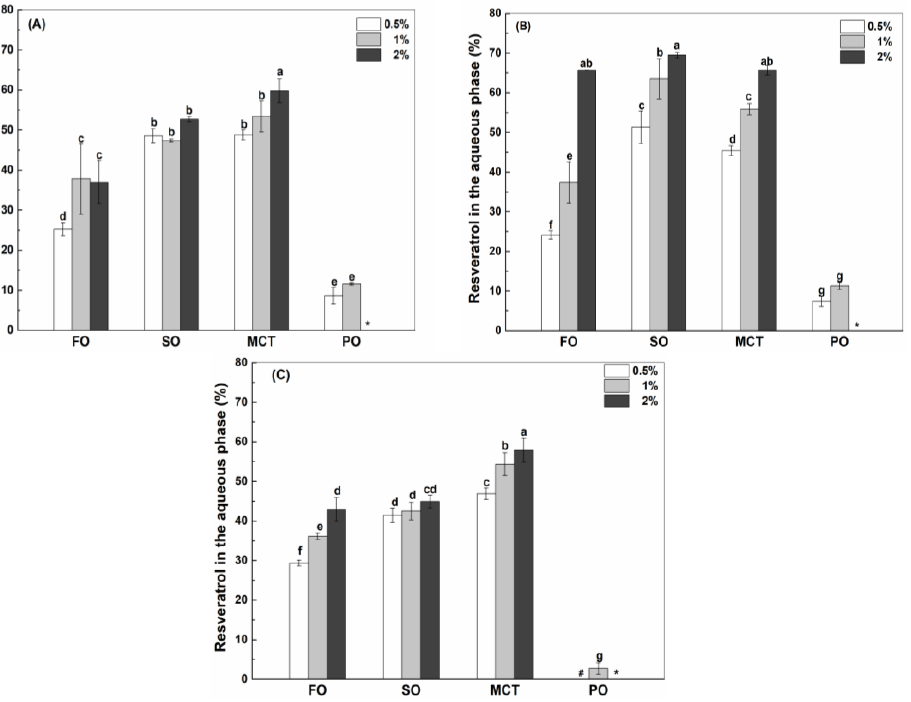
Figure 4. Percentage of resveratrol in the aqueous phase of fish oil (FO), sunflower oil (SO), MCT and peppermint oil (PO) emulsions stabilized by native WPI ( A ), heat-denatured WPI ( B ) and sodium caseinate ( C ) at 0.5%, 1% and 2%. Different letters mean significant differences at p < 0.05. * Peppermint oil emulsions were unstable at 2% proteins. # Resveratrol was not detected. For the use of WPI as an emulsifier, the percentage of resveratrol in the aqueous phase of fish oil emulsions increased from 25% at the protein concentration of 0.5% to 37% at the protein concentrations of 1% and 2% (Figure 4A). The aqueous percentages of resveratrol in sunflower oil emulsions were about 49%, which is independent on WPI concentration. The aqueous percentage of resveratrol in MCT emulsions increased from 49% to 60% as WPI concentration increased from 0.5% to 2%. For comparison, the aqueous percentages of resveratrol in fish oil emulsions were less than those in sunflower oil and MCT emulsions. In the case of hWPI, the aqueous percentage of resveratrol increased from 24% to 66% in fish oil emulsions, from 51% to 69% in sunflower oil emulsions and from 45% to 65% in MCT emulsions, as the protein concentration increased from 0.5% to 2% (Figure 4B). For comparison, the aqueous percentages of resveratrol in fish oil emulsions were less than those in sunflower oil and MCT emulsions at the concentration of hWPI being 0.5% but were similar at 2% hWPI. In the case of SC, the aqueous percentage of resveratrol in fish oil and MCT emulsions increased from 29% to 43% and from 47% to 58%, respectively, as the protein concentration increased from 0.5% to 2% (Figure 4C). The percentage of resveratrol in sunflower oil emulsions were 43%, independent of the concentration of SC. For comparison, the aqueous percentages of resveratrol were ranked in the order of fish oil < sunflower oil < MCT.